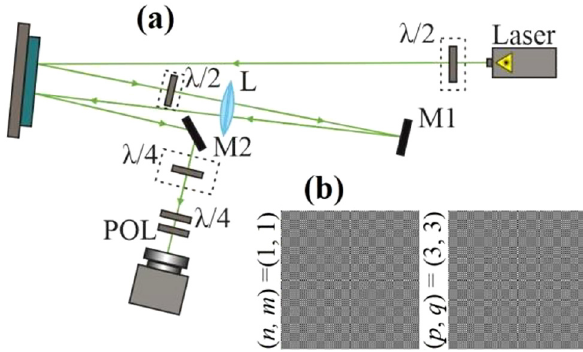
Figure 9: (a) Optical setup for the generation and investigation of the designed uniformly polarized and inhomogeneously polarized vector superpositions of HG modes. Laser is a solid-state laser ( λ = 532 nm), SLM is the spatial light modulator HOLOEYE PLUTO VIS (1920 × 1080 pixels, with a pixel pitch of 8 μ m), L is a lens with a focal length of 350mm,M1andM2aremirrors,POLisapolarizer-analyser, λ /2and λ / 4 are half- and quarter-wave plates, and CAM is a video camera. (b) Examples of the encoded phase masks used in the Simulation and experimental results have shown that it is possible to generate beams whose intensity, polariza- tion, and SAM are structurally stable, even for complex